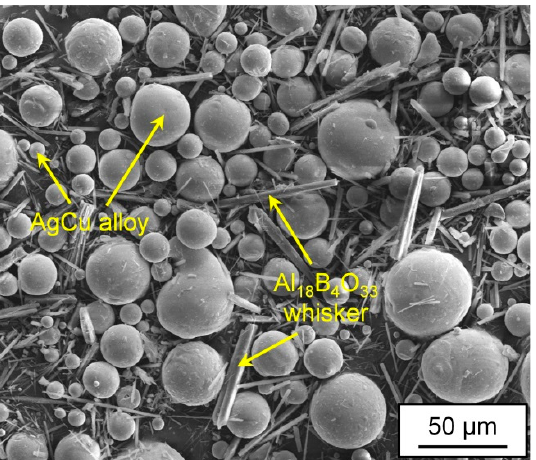
Figure 1. SE SEM image of ABOw-reinforced AgCu composite alloy.